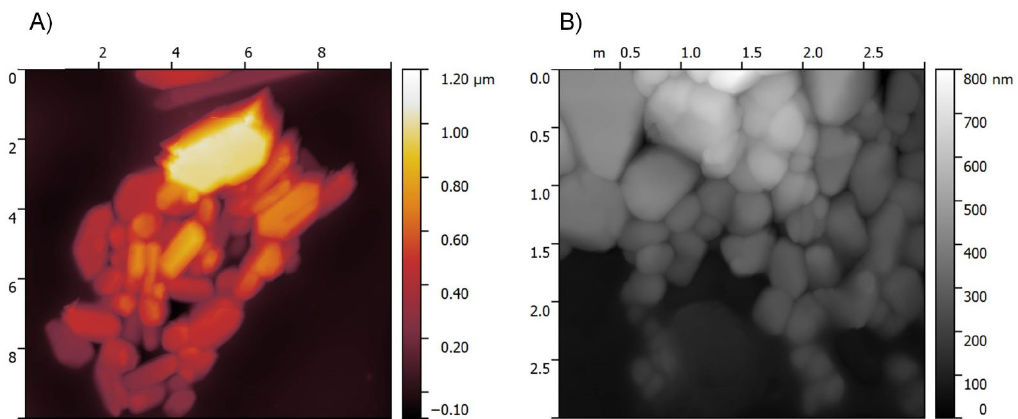
Figure 11. Transmission electron microscopy (TEM) images of cilostazol microcrystals ( A , B ) and nanocrystals ( C , D ). ( A ) magnification 22,000×, scale bar 2 µm; ( B ) magnification 62,000×, scale bar 1 µm; ( C ) magnification 70,000×, scale bar 1 µm; ( D ) magnification 110,000×, scale bar 500 nm.